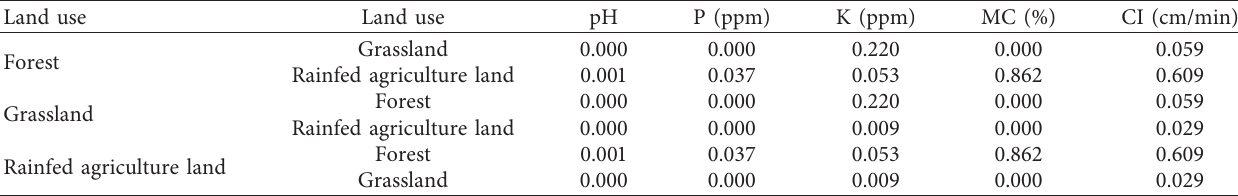
Table 2: LSD comparison between land use systems on soil